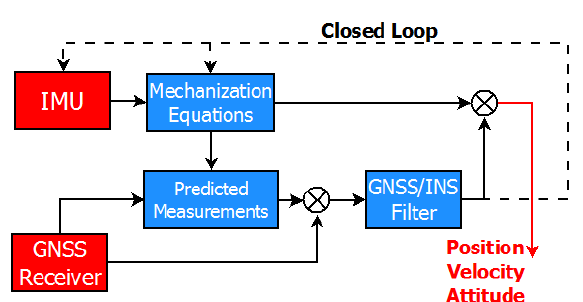
Figure 2. Tightly coupled